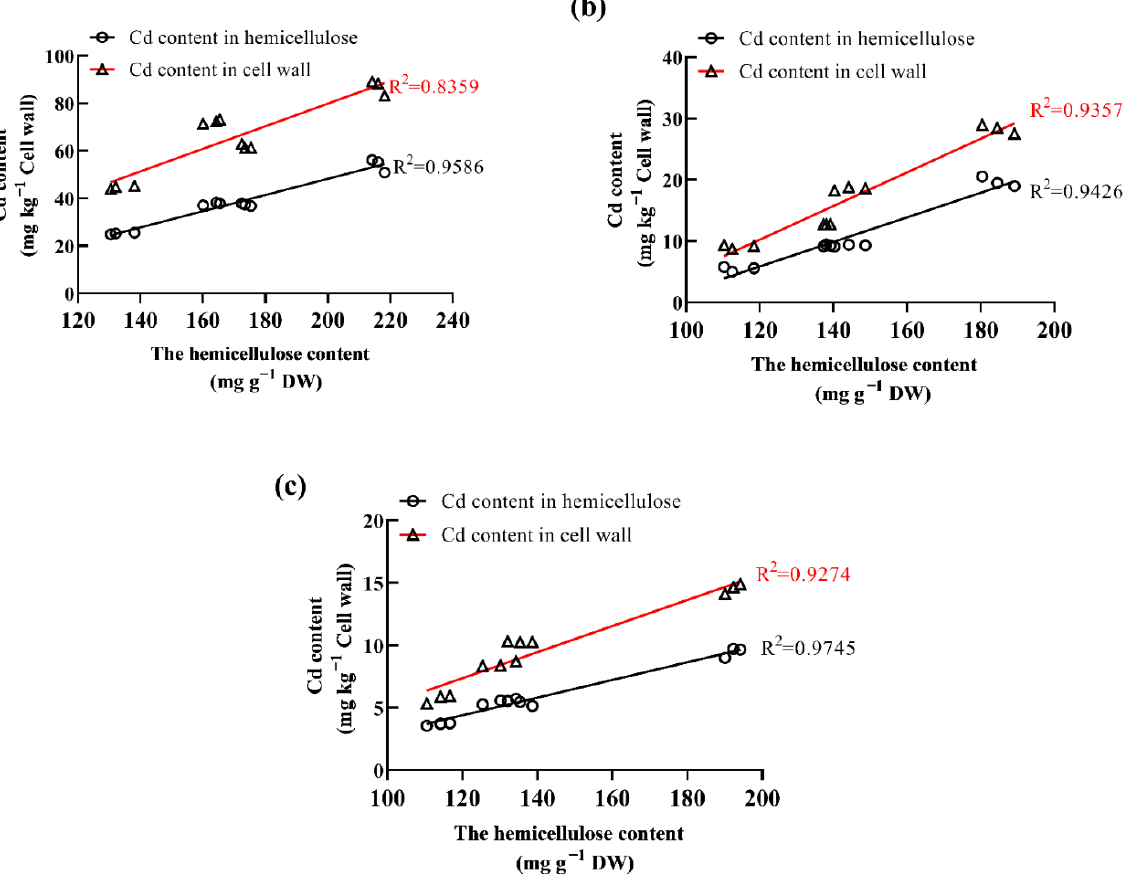
Figure 5. Correlations between the hemicellulose content and Cd concentration in the: ( a ) root; ( b ) stem; ( c ) leaf.